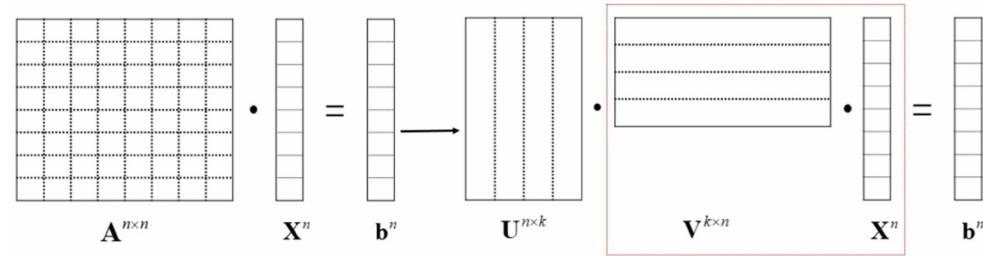
Figure 8. Matrix–vector multiplication order changed using the ACA algorithm.